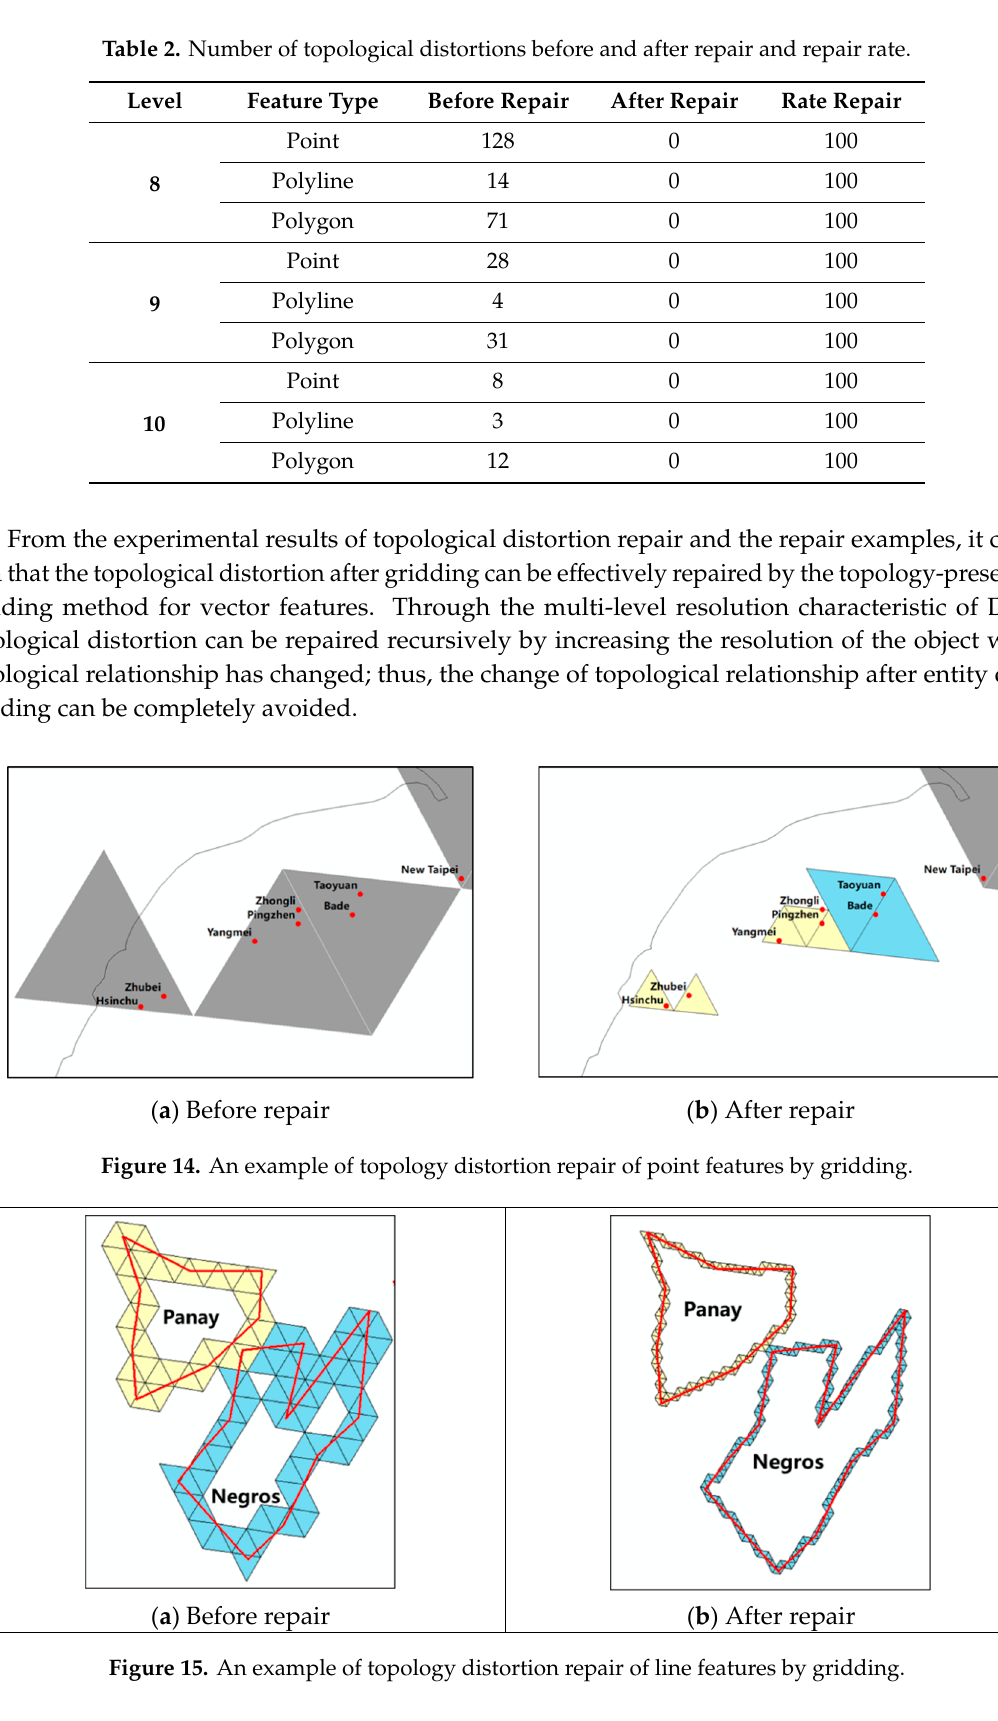
Table 2. Number of topological distortions before and after repair and repair rate.